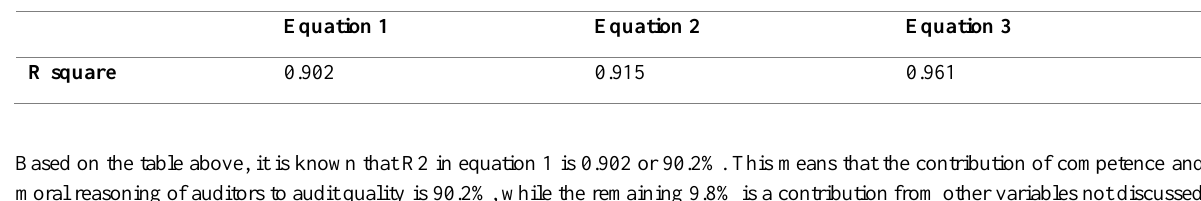
Table 4: Coefficient of Determination Test